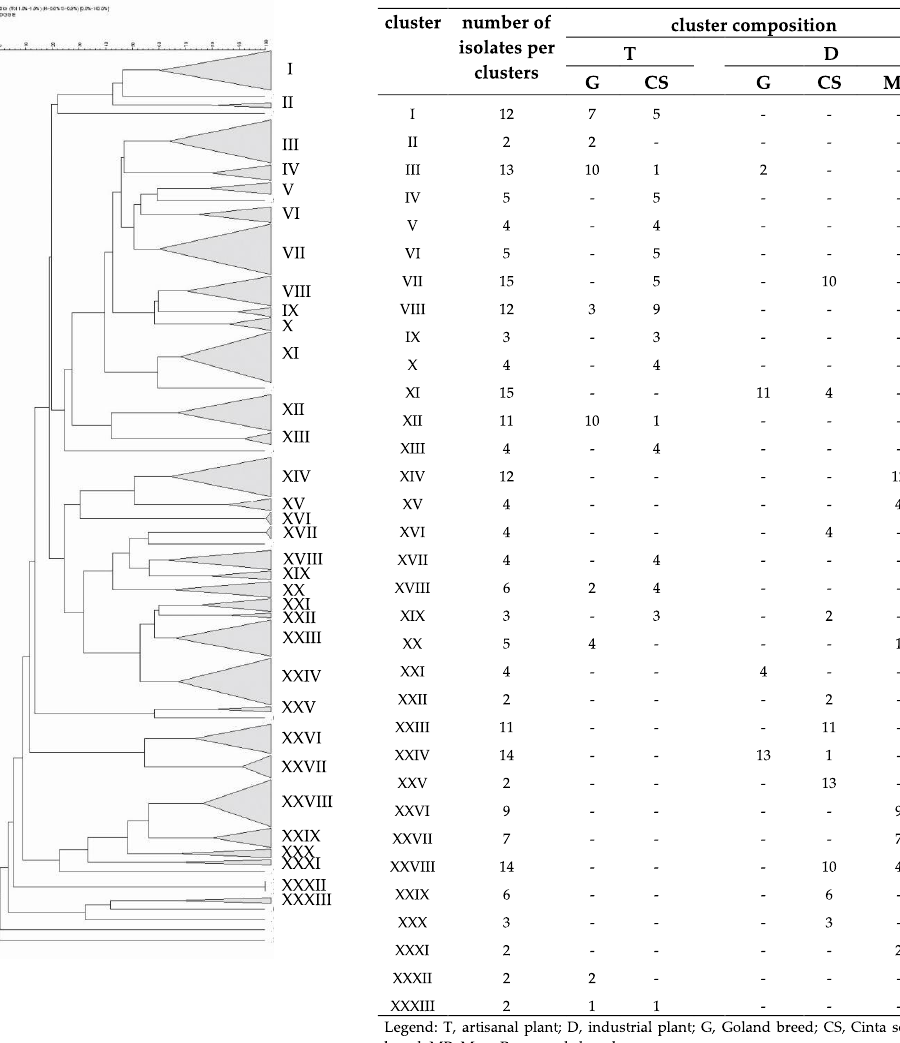
Figure 4. Cluster analysis using Dice product–moment correlation coefficients and unweighted pair group method using an arithmetic average (UPGMA) of the profiles obtained from the fingerprinting analysis of the different fermentations. A similarity coefficient of 60% was arbitrarily chosen. Identified clusters are indicated with roman numerals. Cluster composition is defined in the table within the figure.